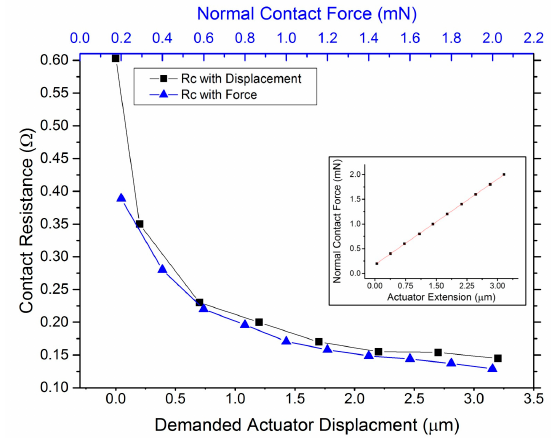
Figure 5. Contact Resistance to Contact Force ( blue triangles ), and Contact Resistance to Contact Demanded Displacement ( black squares ) with Contact Force to Actuator Displacement (inset).